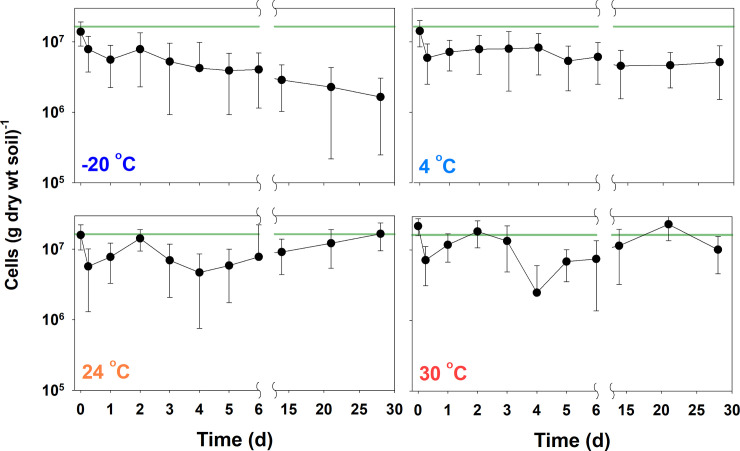
Effects of storage temperature on bacterial numbers.Results were obtained by epifluorescence microscopy (EM) using garden soil samples collected from Korea University. The green lines indicate the initial cell numbers in the soil sample counted within 1 h. All other pretreatment conditions were the same except the storage temperature; vortexed at maximum speed for 5 min, sonication at 300 W for 3 min, centrifugation at 1400 × g for 15 min, and filtration through 10 μm filters. Experiments were conducted in triplicate and data are shown as the mean ± standard deviation.